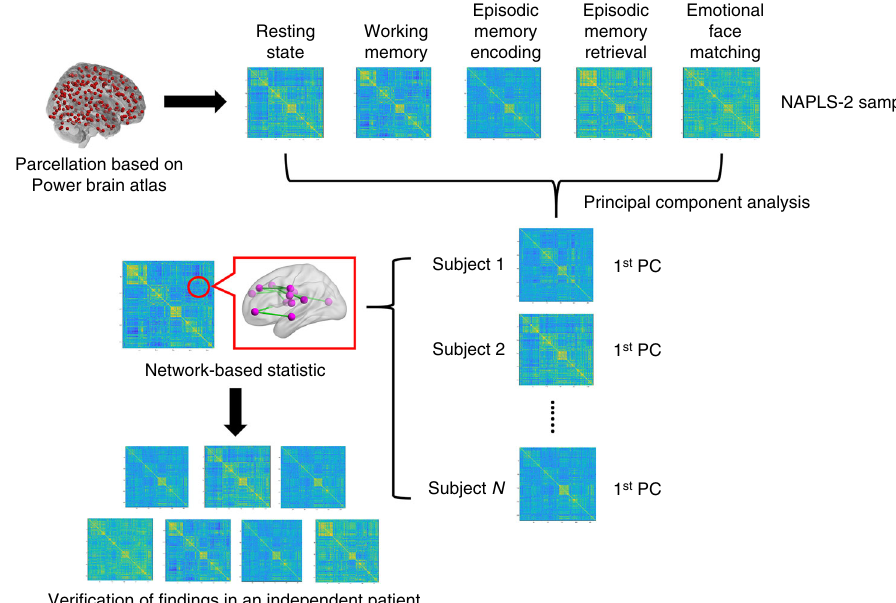
Fig. 1 Flowchart of the processing pipeline used in this study